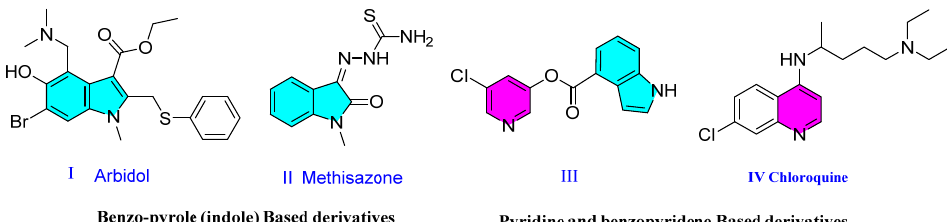
Figure 1. Antiviral drugs having isatin and pyridine moieties.